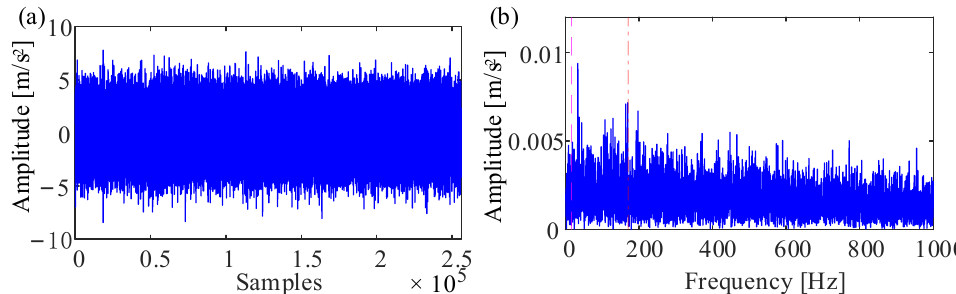
Figure 12. Test results at 1000 rpm: ( a ) raw signal; ( b ) envelope spectrum.